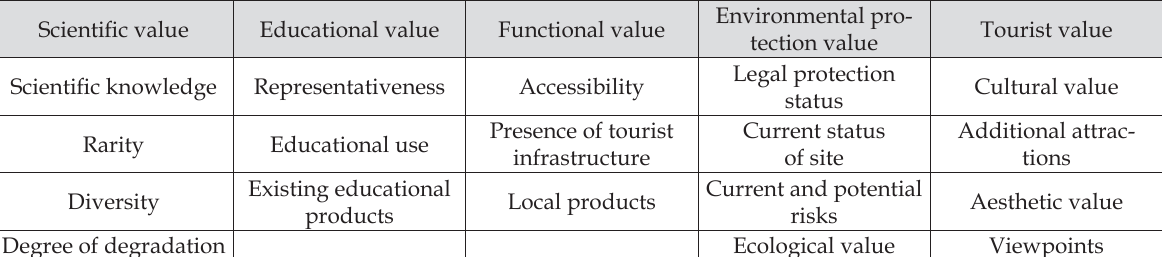
Table 1. Geomorphosite assessment criteria